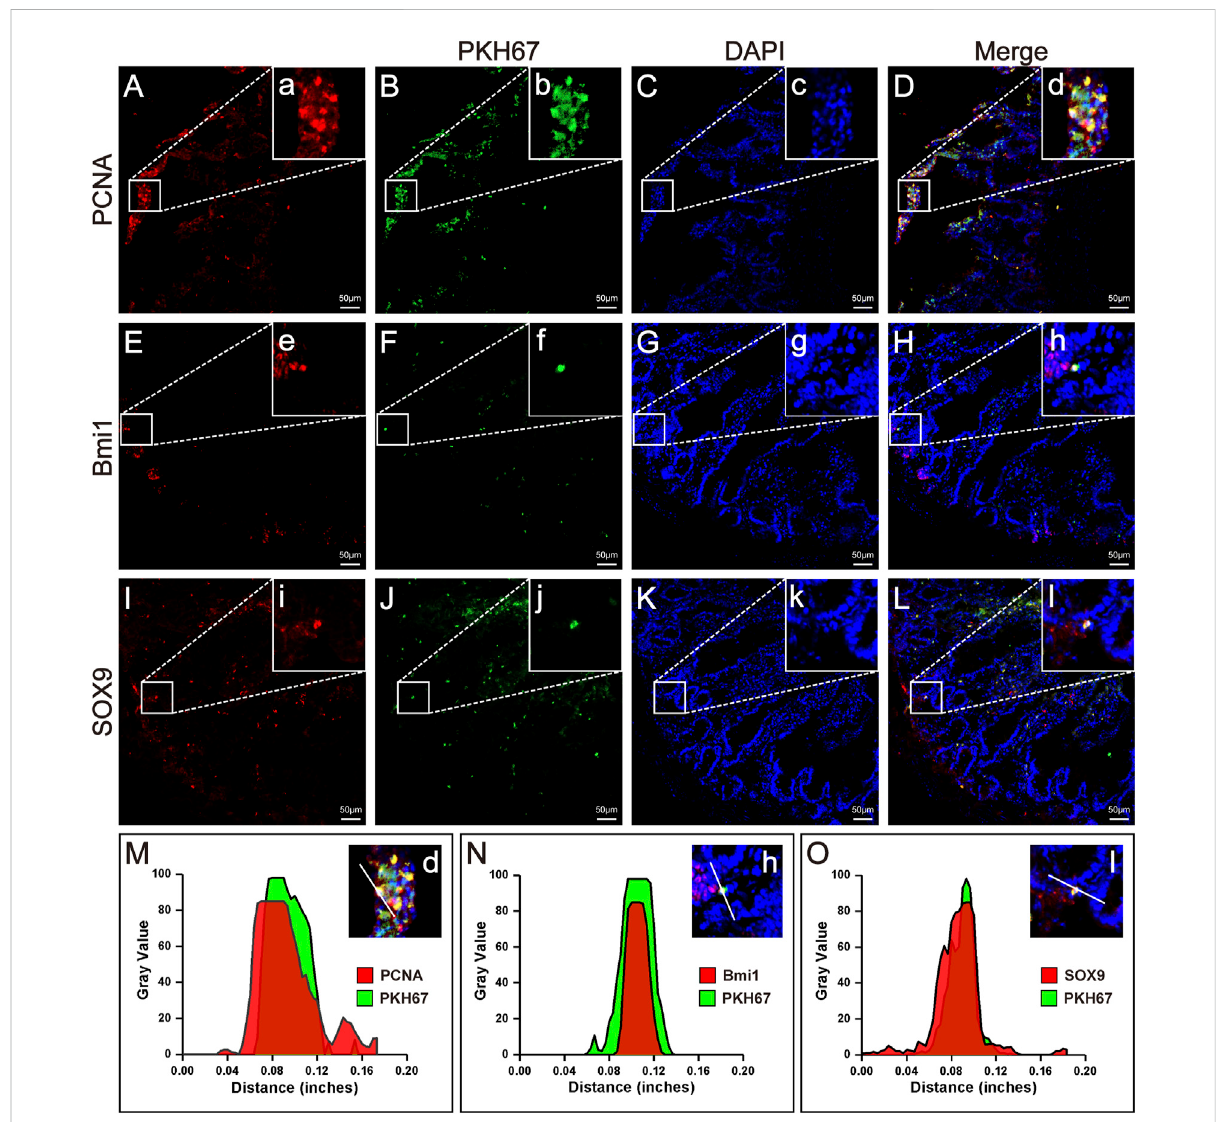
FIGURE 4 Homing, proliferation and differentiation of HFMSCs in IR + HFMSCs group. (A,E,I) Proliferating cell nuclear antigen PCNA (A) and the ISC markers Bmi1 (E) and SOX9 (I) emitted red fl uorescence in small intestinal tissue. (B, F, J) PKH67-labeled HFMSCs homed to the damaged tissue site and emitted green fl uorescence in small intestinal tissue. (C,G,K) DAPI-labeled cells emitted blue fl uorescence. (D,H,L) Merging image from the red, green and blue fl uorescent images. a-l Magni fi ed image of the sites where PCNA, SO×9, Bmi1 and HFMSCs colocalized in A-L. (M – O) Cross- section fl uorescence intensity analysis of the colocalization sites in (D,H,L)